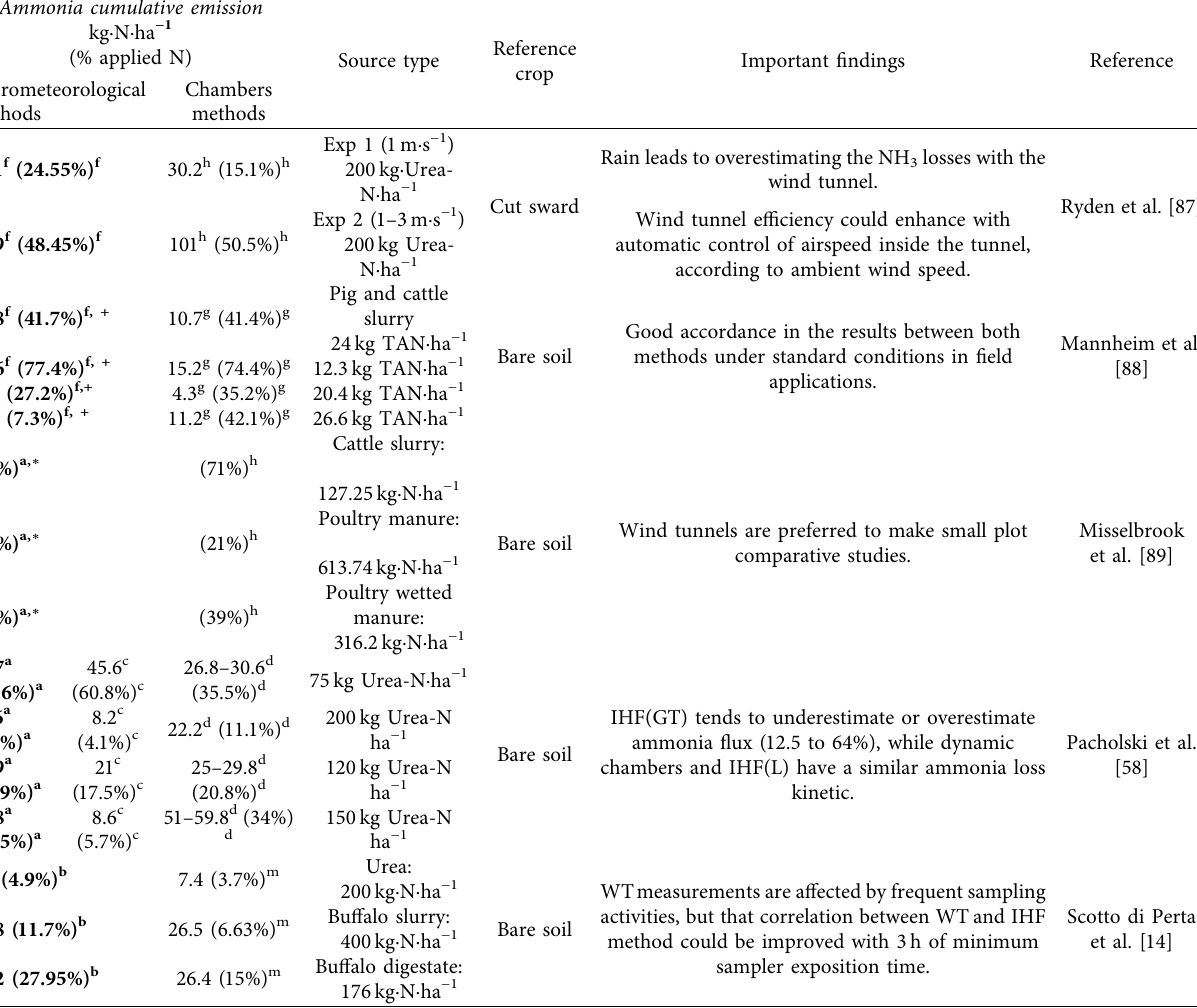
Table 4: Comparison of ammonia cumulative emission in kg Nha − 1 and % applied N determined by different measurement methods. Ammonia cumulative emission kg · N · ha